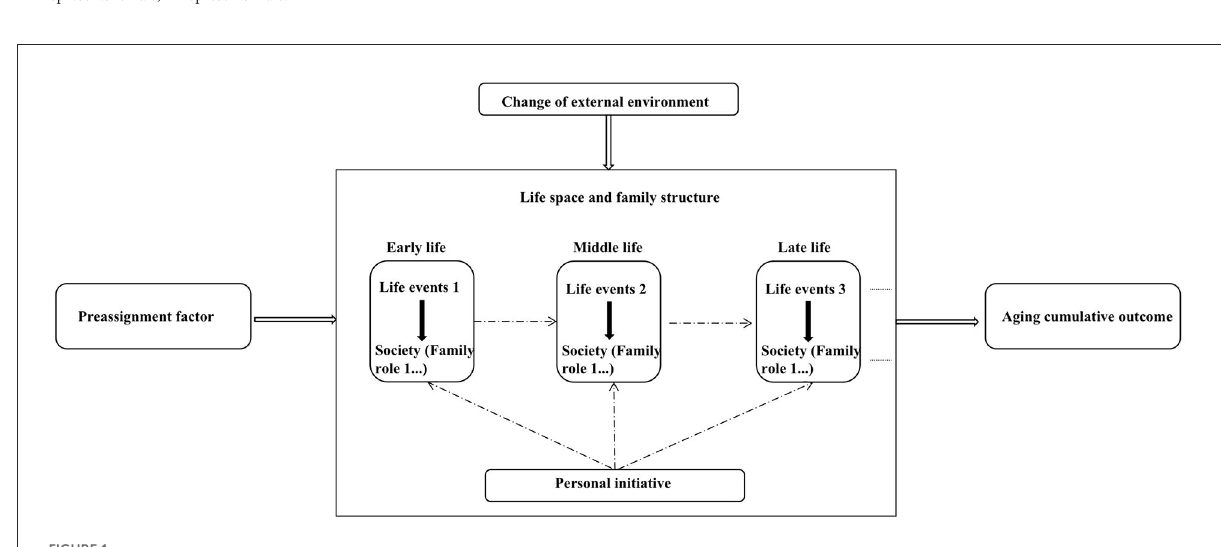
FIGURE1 Life course and digital accumulation of rural elderly.